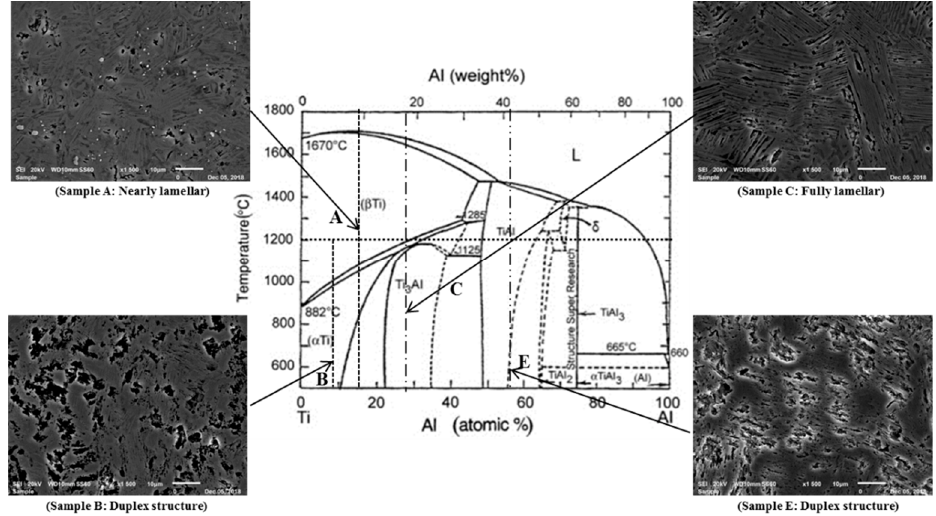
Figure 8. Microstructures of the alloys after heat treatment.